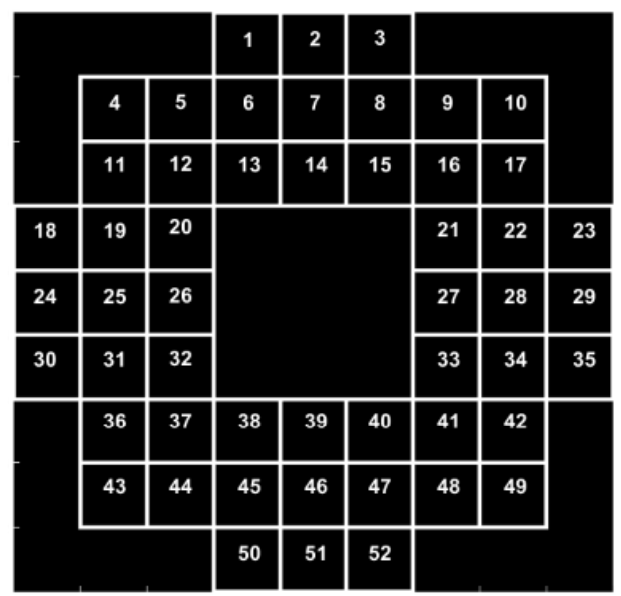
Figure 3. The arrangement and numbers of the sub-apertures of the S-H WFS.